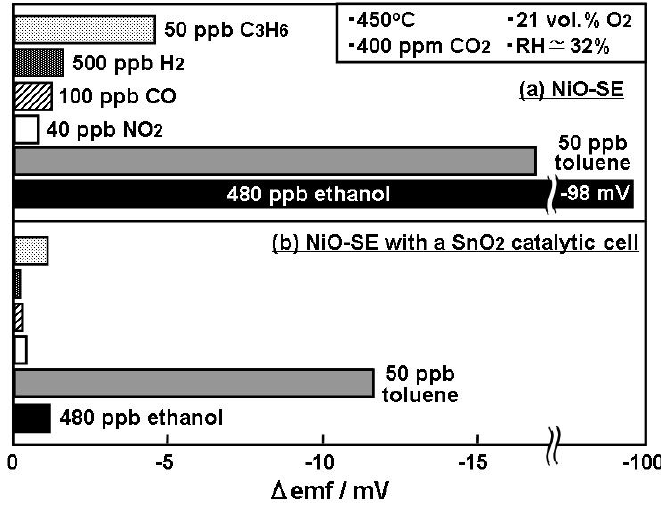
Figure 5. Comparison of cross sensitivities towards different gases ( a ) YSZ-based sensor utilizing NiO-SE; ( b ) YSZ-based sensor utilizing NiO-SE with SnO operational temperature of 450 °C under humid conditions (RH ⋍